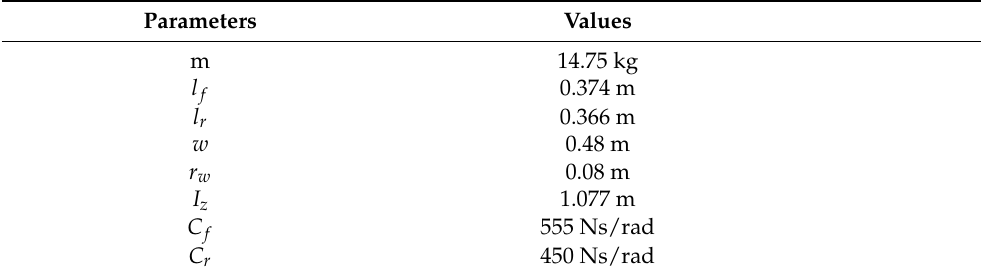
Table 1. Parameters of the scaled-down vehicle.